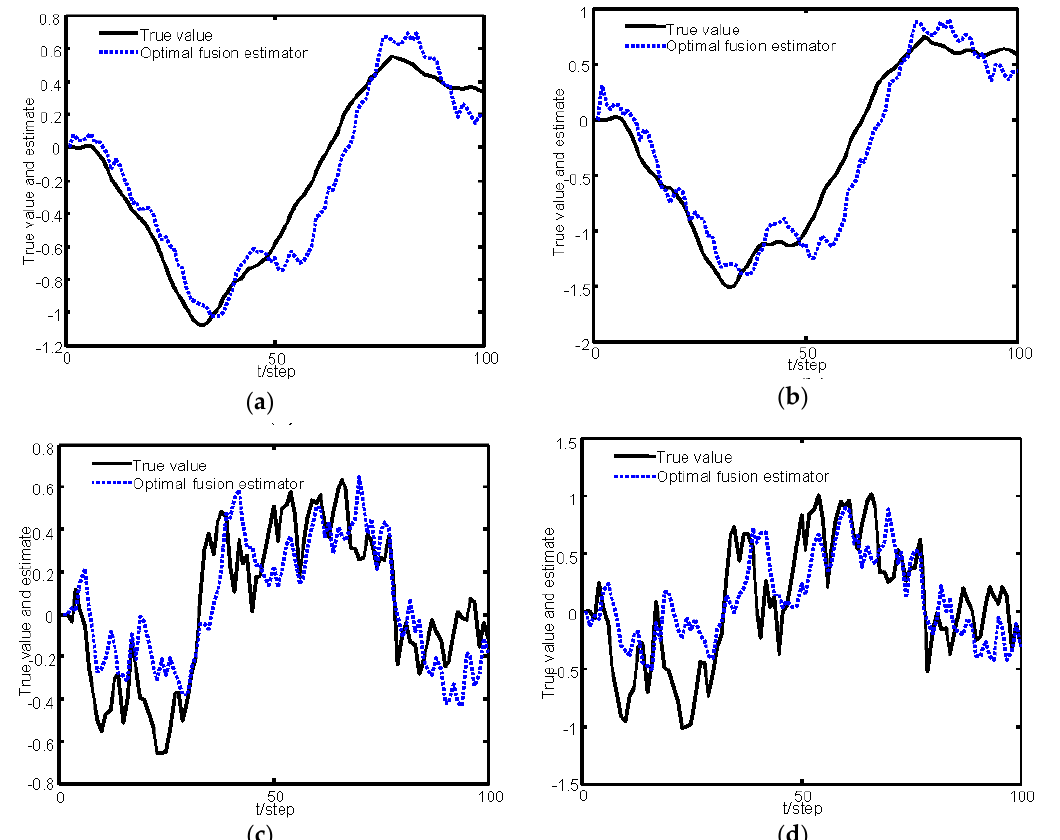
Figure 2. Samples of sensors 1–3 in [1,20]: ( a ) samples of the first sensor; ( b ) samples of the second sensor; and ( c ) samples of the third sensor.